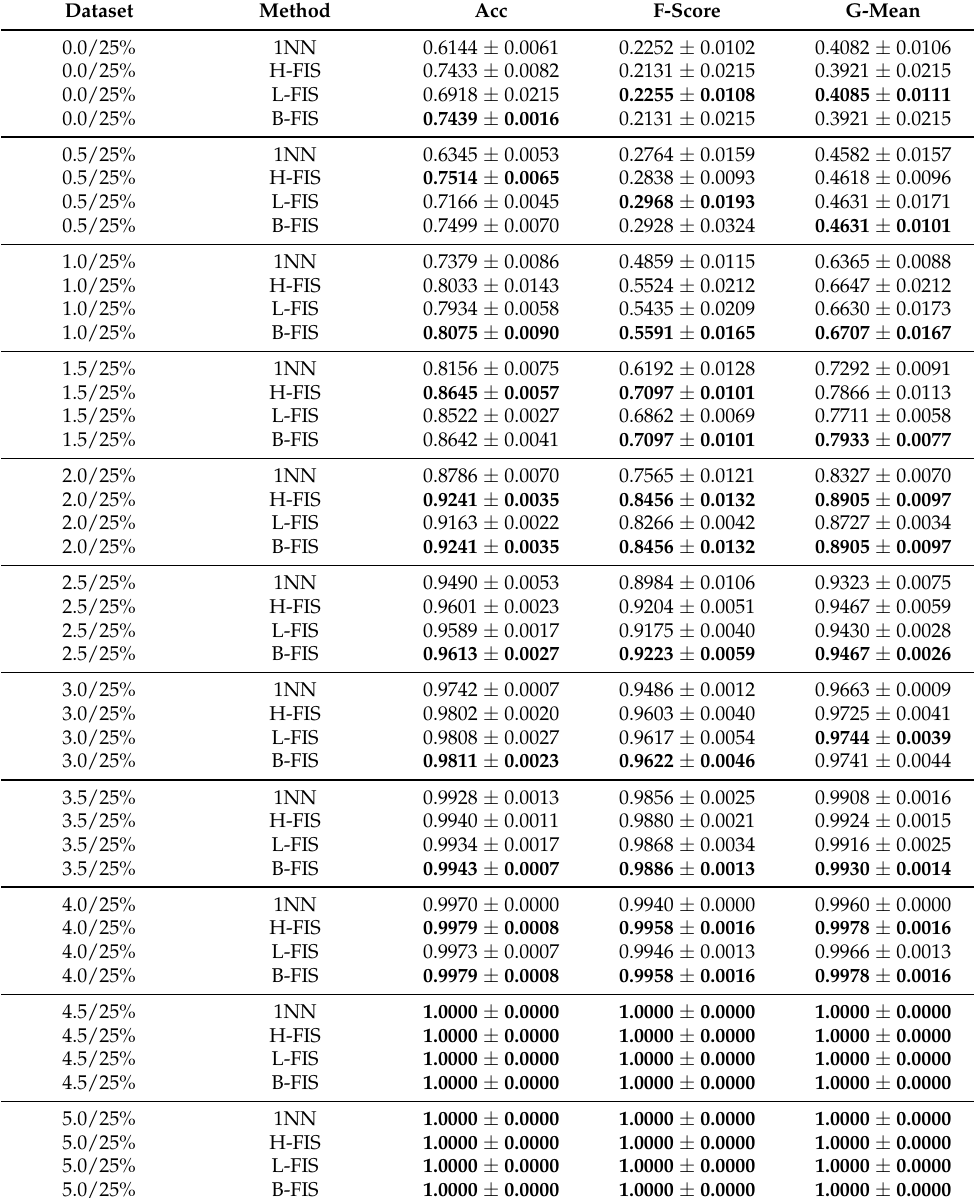
Table 5. Results for artificial dataset with 25% of positive